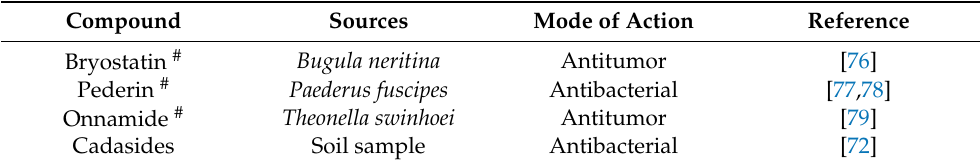
Table 2. Natural products identified/studied by sequencing-based